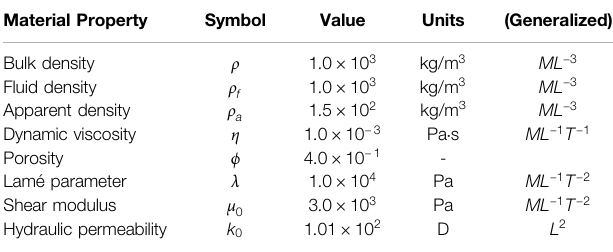
TABLE 1 | The fi rst six material properties were used in both MRE f and MRE i . The last two are background values used only in MRE f . Inclusions have